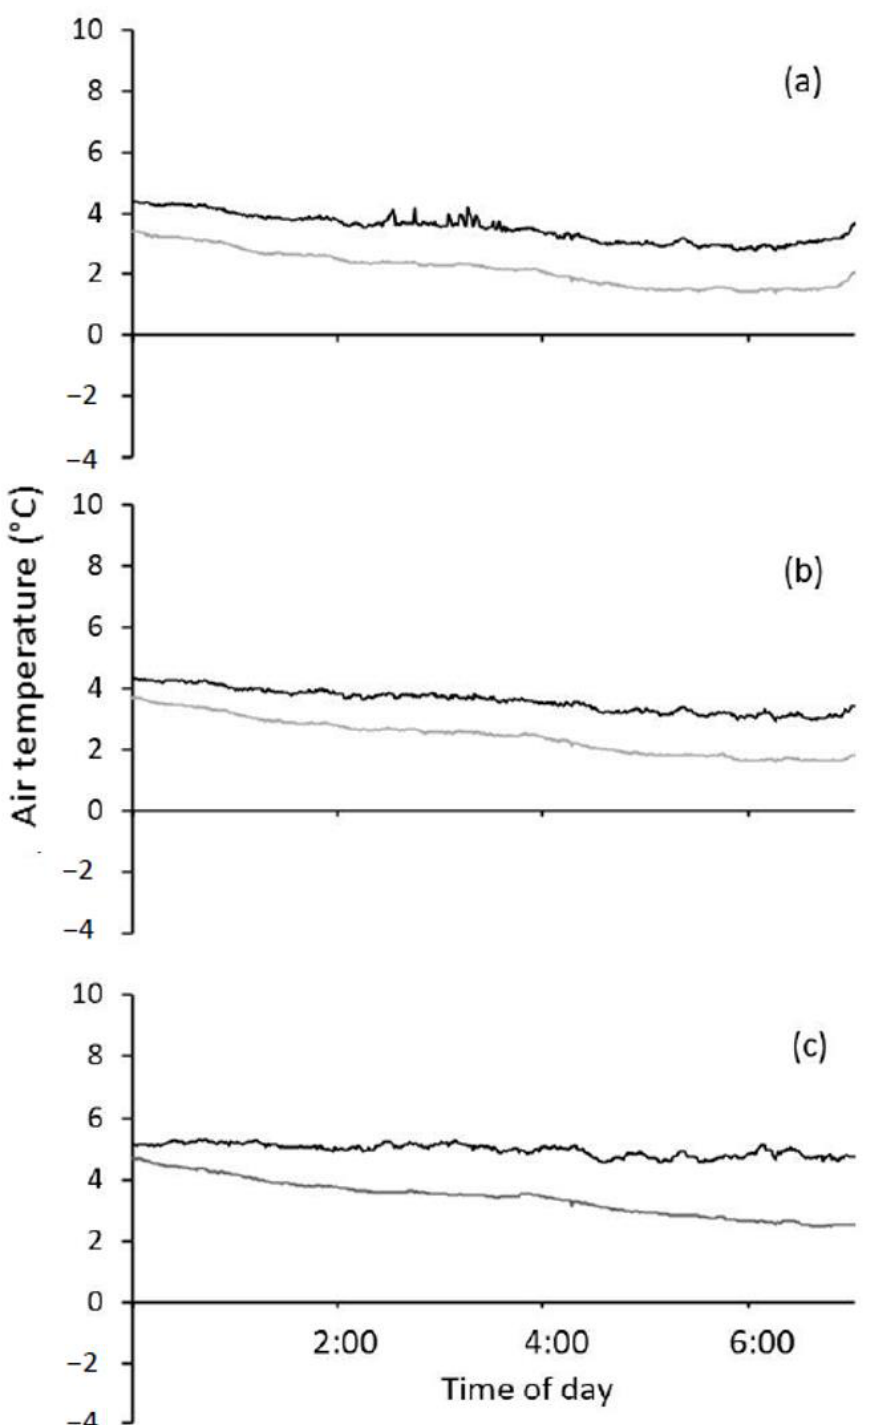
Figure 7. Average air temperature recorded in heated (black line) and adjacent unheated (grey line) plots ( n = 3) at 1000 mm ( a ), 800 mm ( b ) and 400 mm ( c ) above ground level from frost events during July to October 2019. Air temperatures were measured by an unshielded thermocouple (T − type, Temperature Controls Pty. Ltd., Sydney, NSW, Australia) in mid − April − sown Wyalkatchem wheat plots.